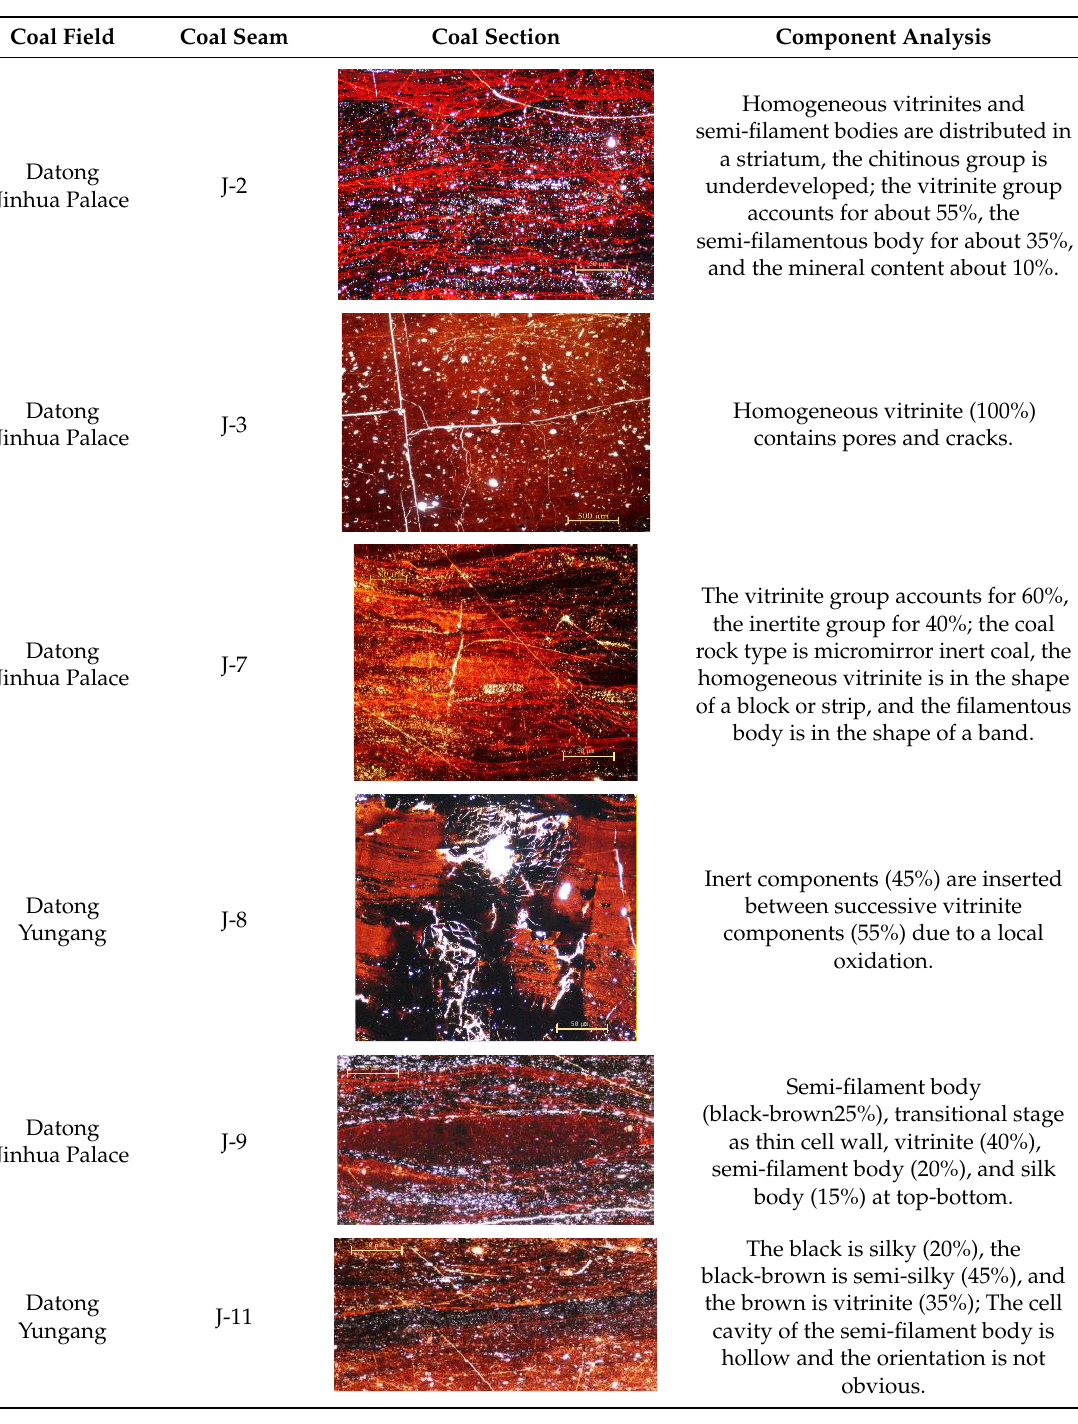
entation is not obvious. Structural vitrinites (60%), the Structural vitrinites (60%), the Structural vitrinites (60%), the cell structure (40%) is obvious, cell structure (40%) is obvious, cell structure (40%) is obvious, neatly arranged, into a honey- neatly arranged, into a honey- neatly arranged, into a honey- comb shape, as cell wall swells comb shape, as cell wall swells comb shape, as cell wall swells absorbing water and cell cavity absorbing water and cell cavity